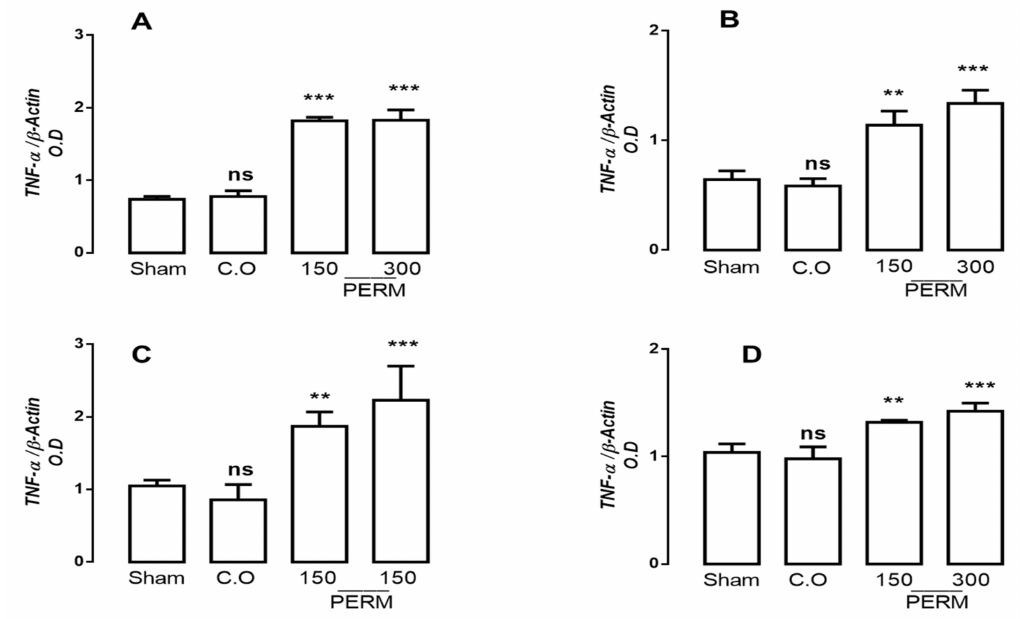
Figure 4. mRNA expression for TNF α in the cerebellum ( A ), cerebral cortex ( B ), cerebral hemispheres ( C ) and medulla ( D